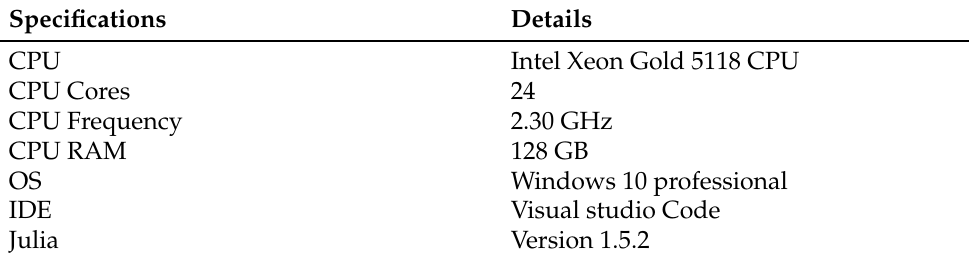
Table 3. Specifications of the workstation computer for performing the benchmark tests.